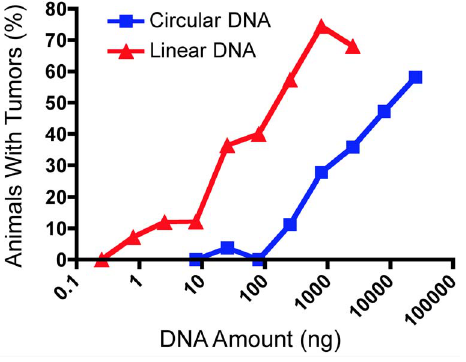
Figure 4. Linear DNA is more oncogenic than circular DNA. Data from the Table 1 were plotted using GraphPad Prizm 5. doi:10.1371/journal.pone.0108926.g004 Cell lines from tumors induced by circular DNA are shown in Fig. 5. In Fig. 5A, the membrane is probed with the c- myc gene, while in Fig. 5B, it is probed with the H- ras gene. Lanes (a) contain DNA from NIH/3T3 cells. As we reported previously, the endogenous c- myc gene is detected by the homologous mouse c- myc probe, whereas the human H- ras probe does not detect the mouse H- ras gene, at least at the hybridization stringency used [5]. No two cell lines have the identical pattern of hybridizing bands, indicating that all of the tumors were independently derived. In many cases, one or a few bands were present (lanes c, d, f, g, h, j, k,